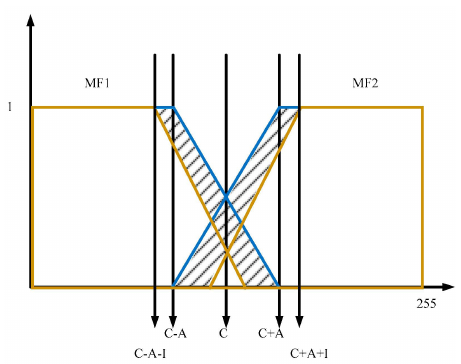
Figure 10. Fuzzy sets of the gradients.